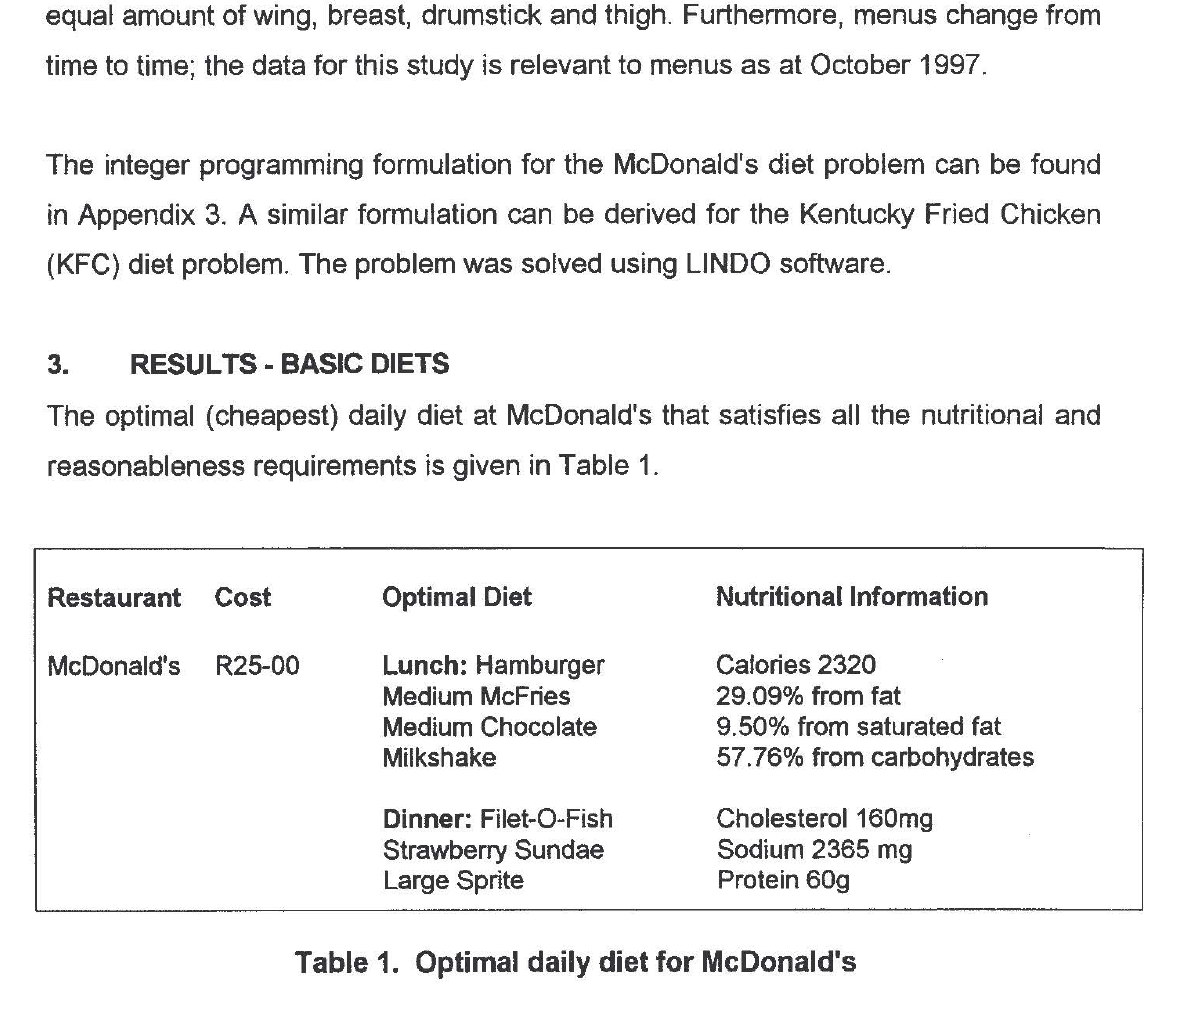
Table 1. Optimal daily diet for